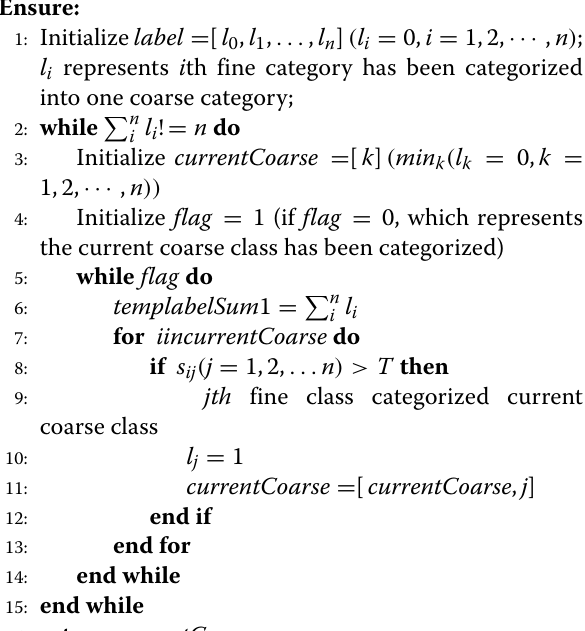
Algorithm 1 Clustering fine categories into coarse cate-